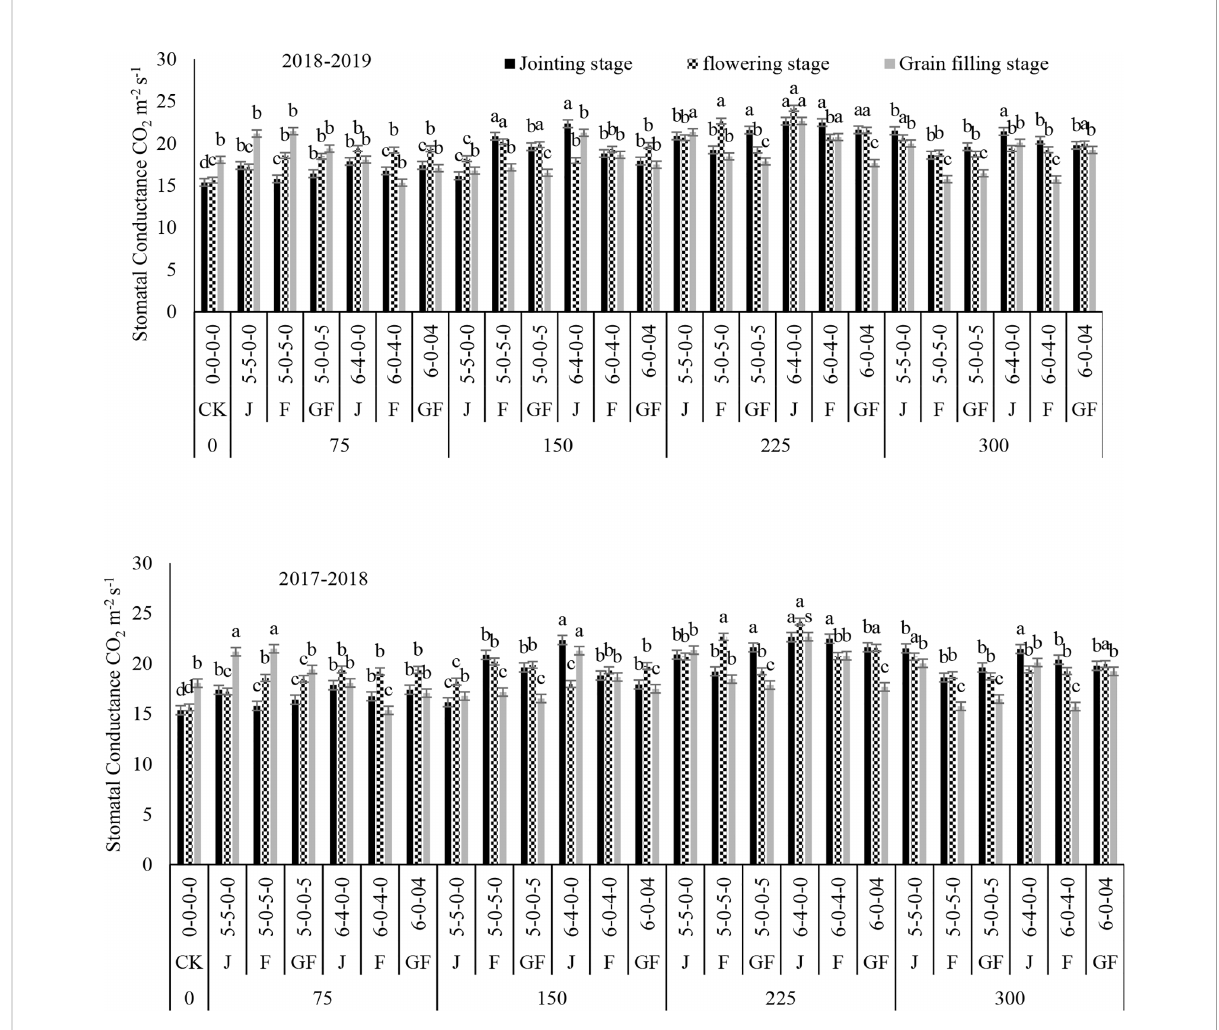
FIGURE 3 Effect of nitrogen fertilizer management on the stomatal conductance of winter wheat. JS , jointing stage; FS , fl owering stage; GF , grain fi lling stage. Different letters in above bars indicate a signi fi cant difference